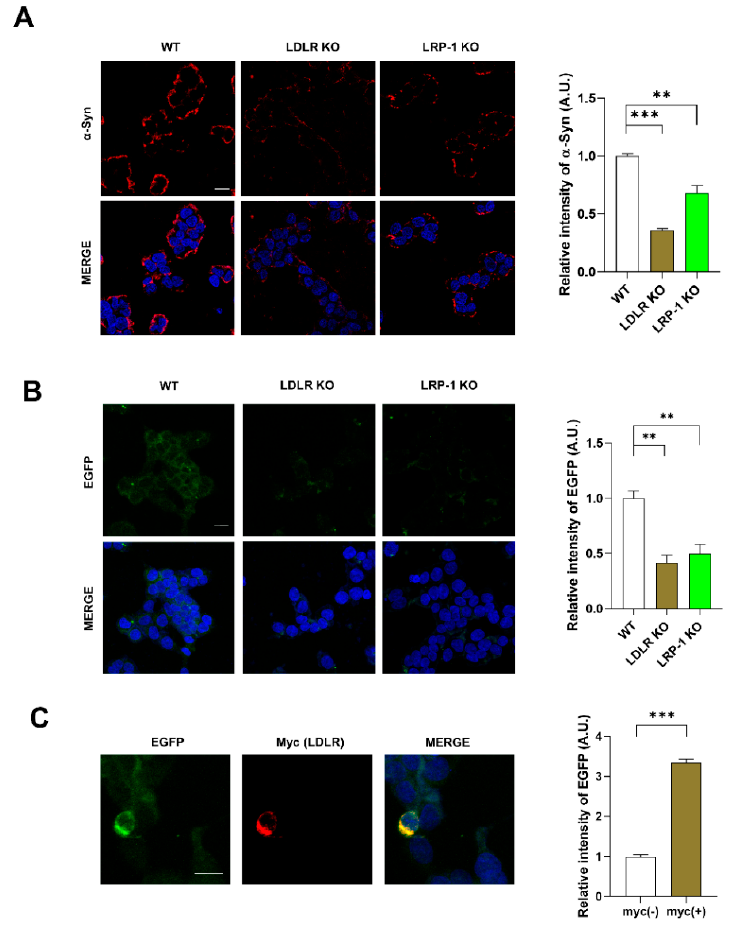
Figure 3. LDLR and LRP-1 expressed in SH-SY5Y cells function as receptors responsible for α -syn uptake. ( A ) LDLR KO and LRP-1 KO SH-SY5Y cells were treated with 1 μ M α -syn fibrils for 30 min, and the cells were then fixed and immunostained with an anti- α -syn antibody. Values were derived from three independent experiments ( n = 3). ( B ) LDLR KO and LRP-1 KO SH-SY5Y cells were co-cultured with differentiated A53T α -syn-EGFP OE SH-SY5Y cells for 24 h using a dual chamber. The cells were then fixed and immunostained with an anti-EGFP antibody. Values were derived from three independent experiments ( n = 3) ( C ) SH-SY5Y cells were transfected with a plasmid for LDLR-myc. The cells were co-cultured with differentiated A53T α -syn-EGFP OE SH-SY5Y cells for 24 h using a dual chamber. The cells were then fixed and immunostained with anti-Myc and anti-EGFP antibodies. Values were derived from three independent experiments ( n = 3). ** p < 0.01, *** p < 0.001 against the control; one-way ANOVA or unpaired t-tests. Blue indicates DAPI staining. Scale bars indicate 20 μ m.